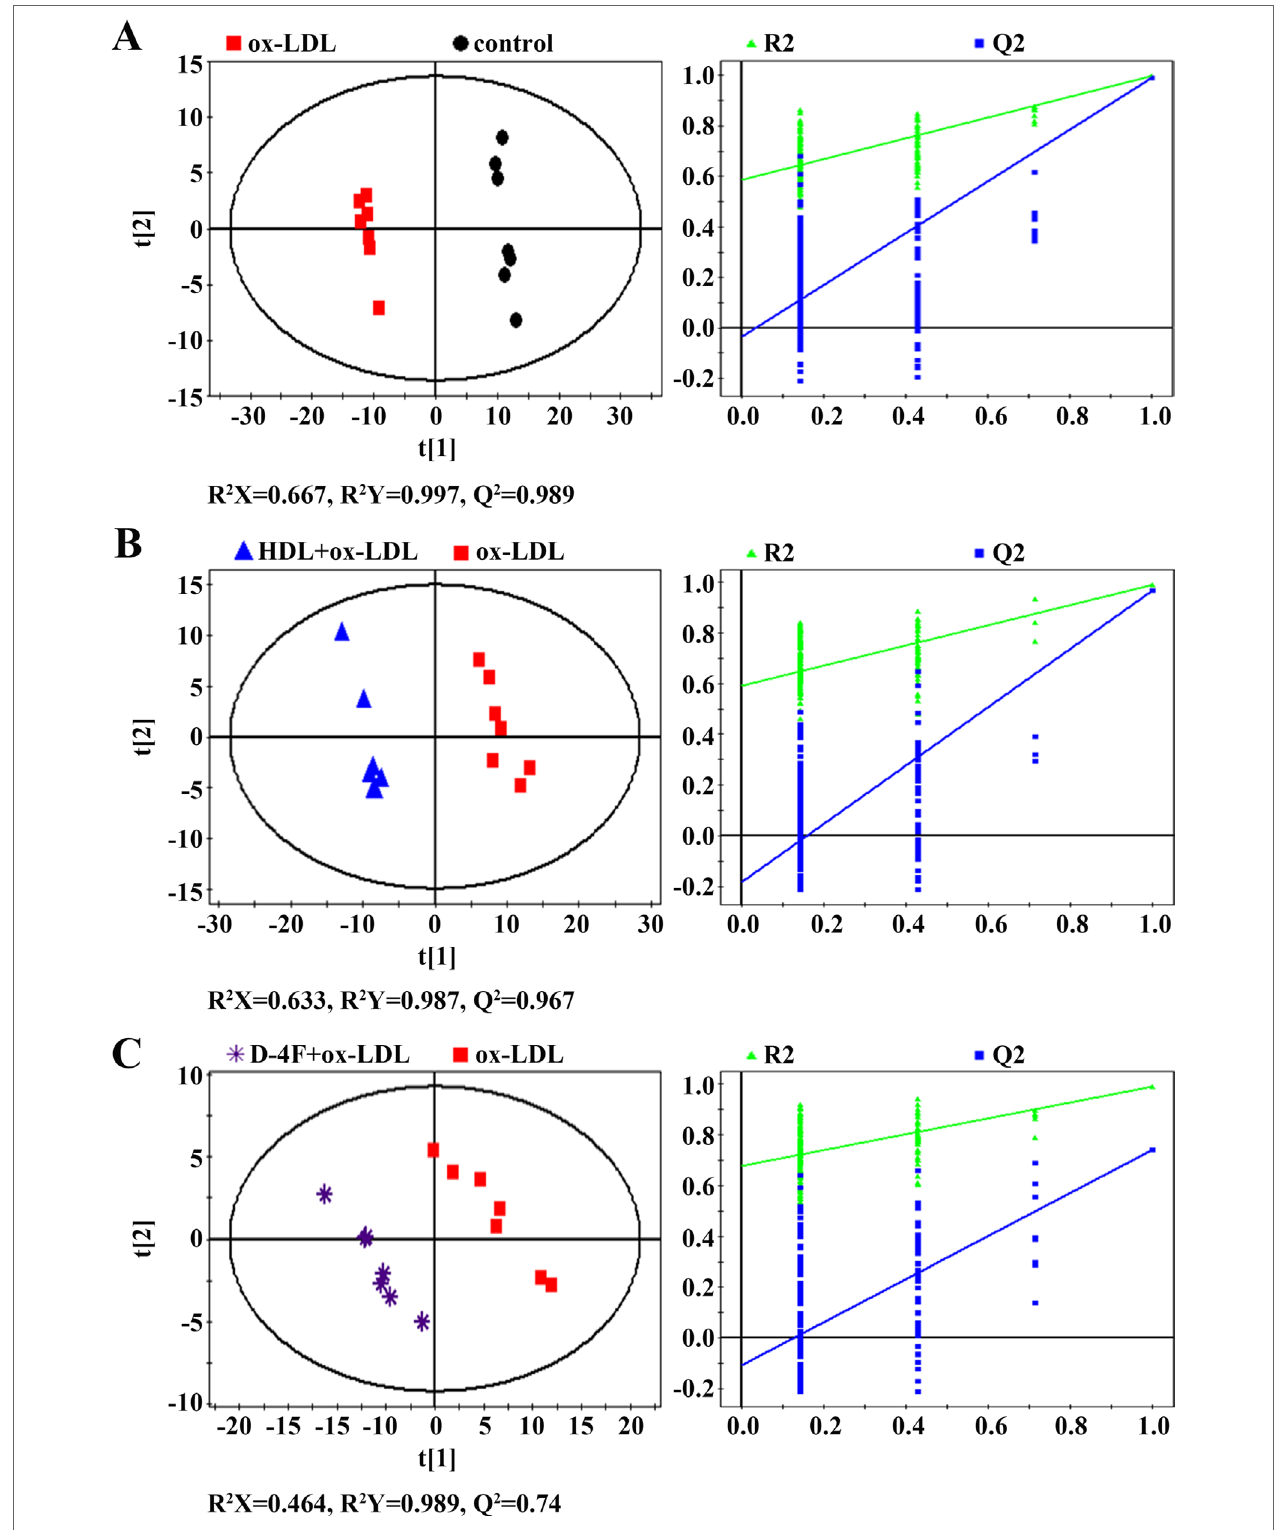
FIGURE 4 | PLS-DA scores plots (left) and cross-validation plots (right) from permutation tests (n = 200) for 1 H NMR spectra recorded on aqueous extracts derived from endothelial cells. (A) ox-LDL vs . control; (B) HDL + ox-LDL vs. ox-LDL; (C) D-4F + ox-LDL vs.